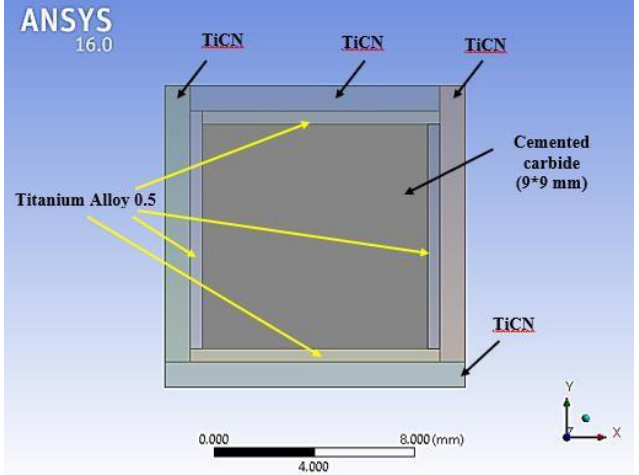
Fig. 25. Three layers cemented carbide, titanium alloy (0.5 mm) and TiCN